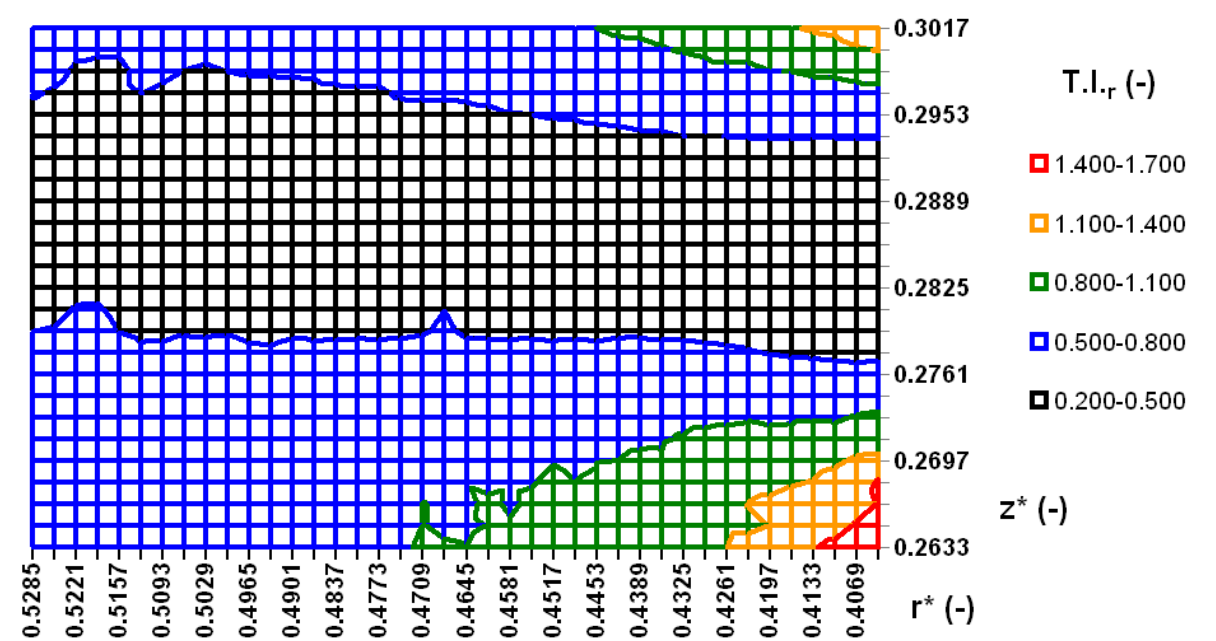
Fig. 11. Radial turbulence intensity distribution T.I. r = f ( r * , z * ) in the impeller discharge